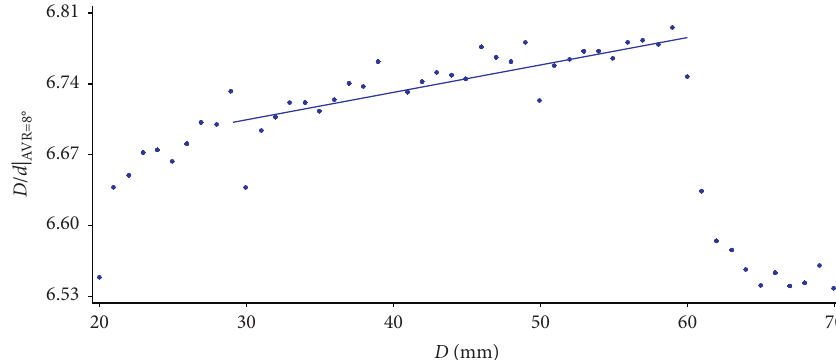
Figure 5: Variation of the D / d value corresponding to the AVR of 8 ° as D varies.